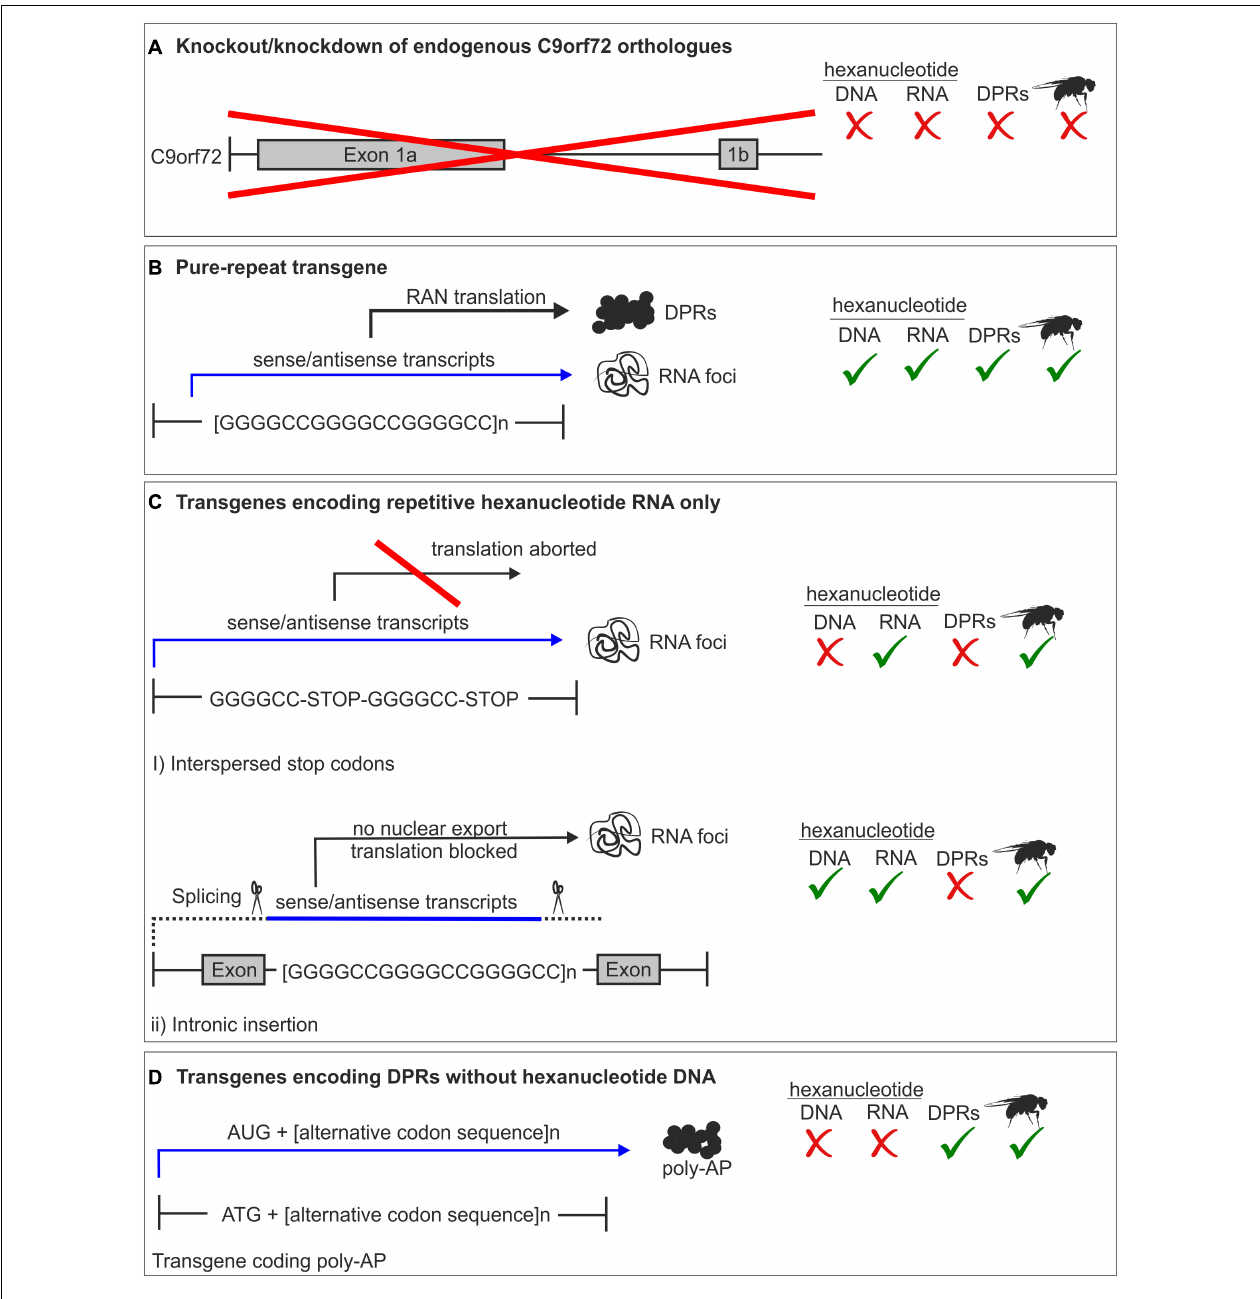
FIGURE 2 | Summary of C9orf72 models. (A) Complete or partial knockout of the endogenous C9orf72 gene. Drosophila does not have a C9orf72 homolog, therefore a knockout model is impossible in fly. (B) Pure repeat models contain the hexanucleotide sequence, and produce all dipeptide repeat proteins (DPRs) along with repeat RNA. (C) RNA-only models are either intronic or have interspersed stop codons to prevent translation. Therefore, only repeat RNA and not DPRs are produced. (D) DPR models use an alternative codon sequence to produce one DPR protein and lack the hexanucleotide